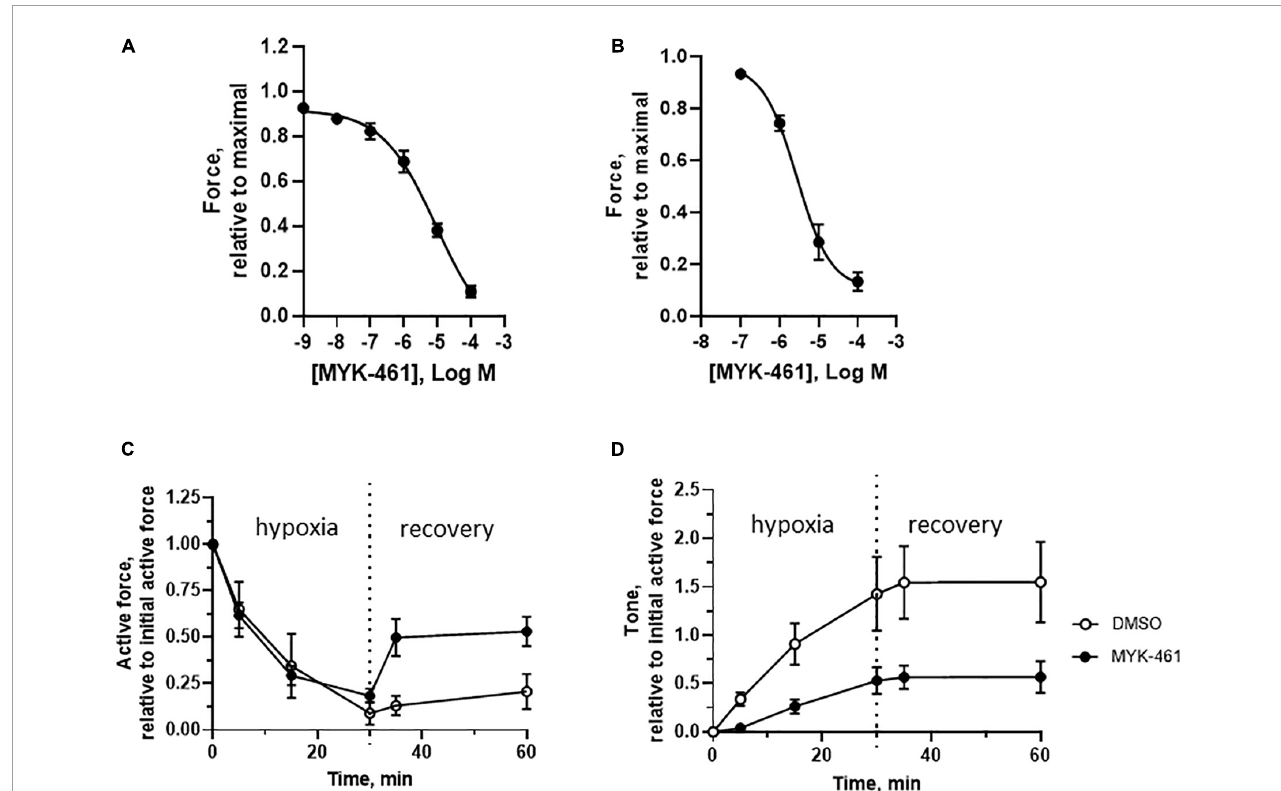
FIGURE7 In vitro effects of MYK-461 (Mavacamten) on cardiac muscles. (A,B) Inhibitory effect on active contraction of MYK-461 in intact trabecular ( A , EC 50 = 9.3 µ M) and in skinned cardiac fibers at pCa 4.7 ( B , EC 50 = 2.8 µ M). Summarized data of active force (C) and tone (D) in non-treated controls and preparations incubated with 1 µ M MYK-461 (initial time = 0, hypoxia/ischemia time = 0–30 min, recovery time = 30–60 min). MYK-461 was introduced 20 min prior to hypoxia/ischemia, and maintained during the challenge period. The MYK-461 group had significantly lower tone during both the hypoxia/ischemia and recovery periods, and higher active force during recovery ( p < 0.05 for both comparisons, repeated measures, ANOVA). N = 4–8 trabeculae in each group (from four to six animals in each